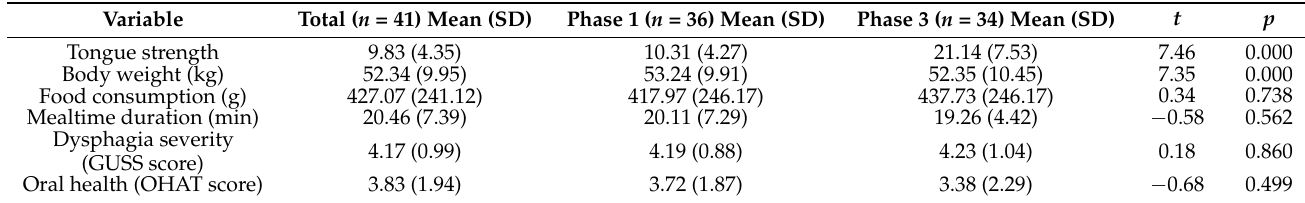
Table 3. Baseline outcomes of the